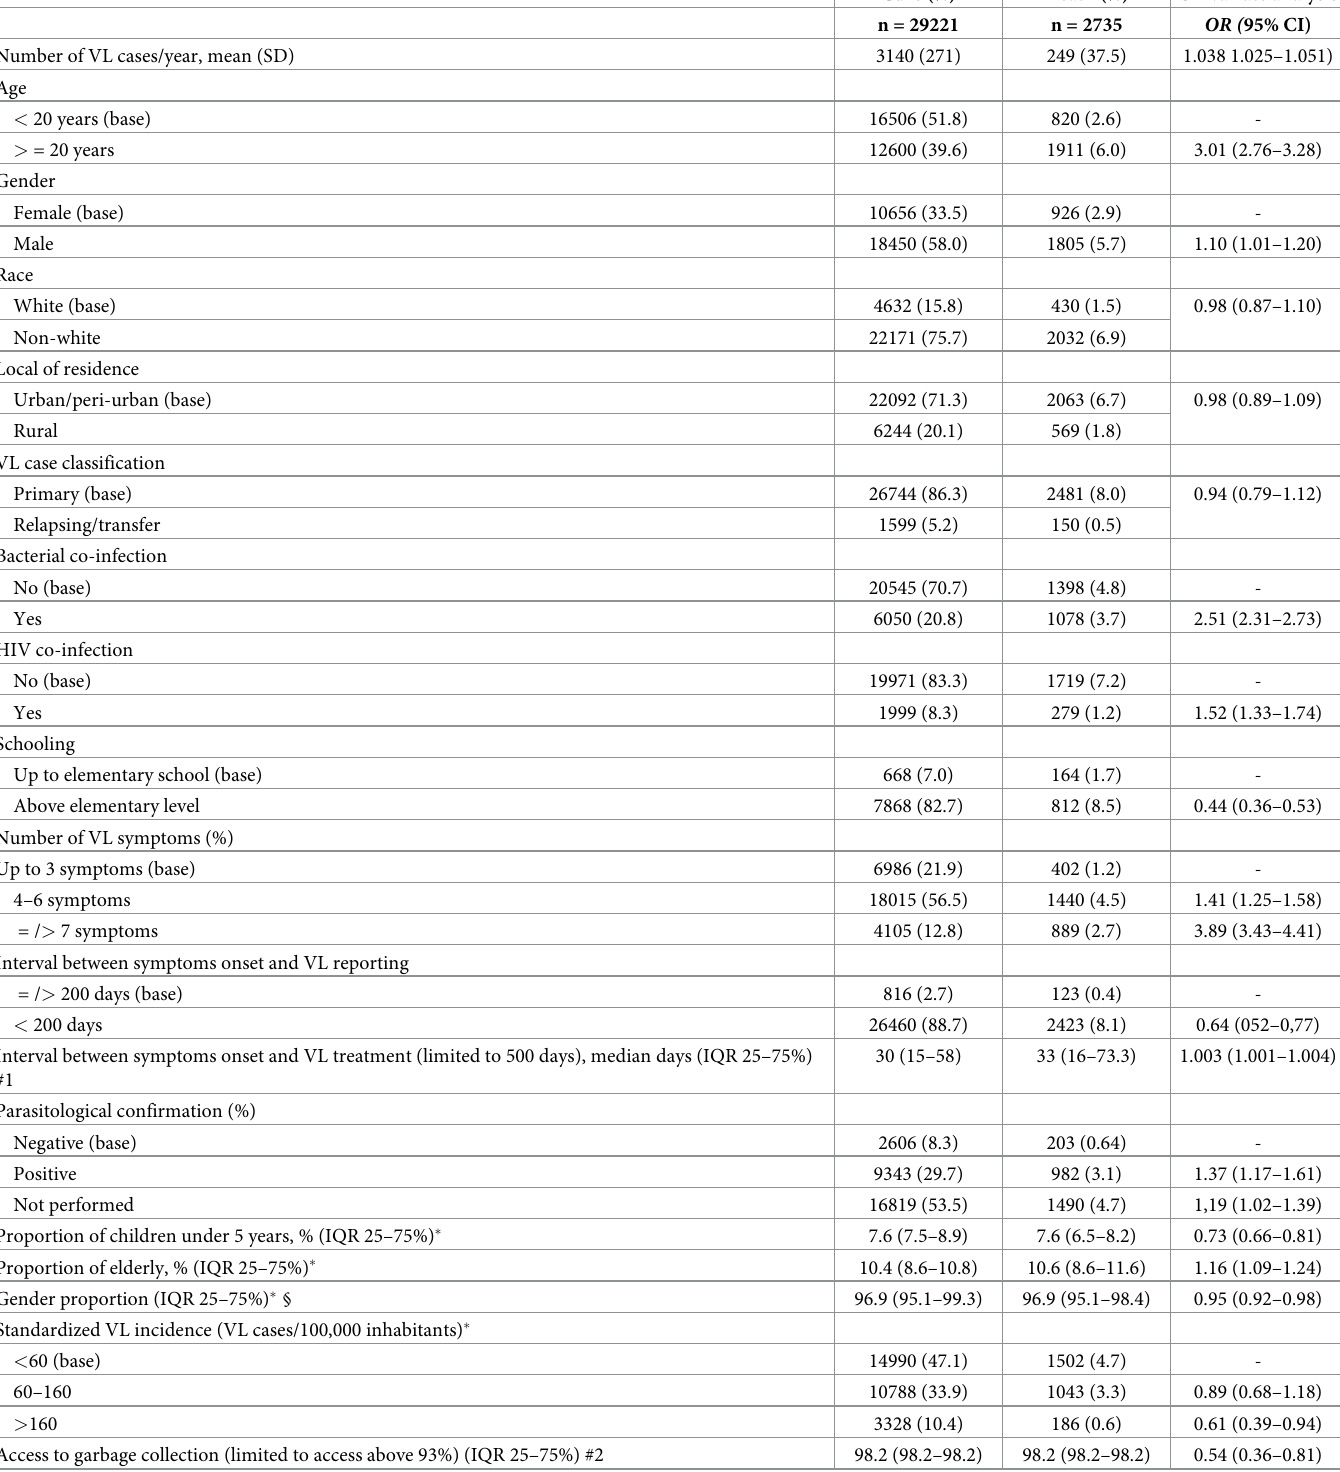
Table 4. Association between contextual/individual factors and VL case-fatality in univariate analysis (Generalized linear mixed